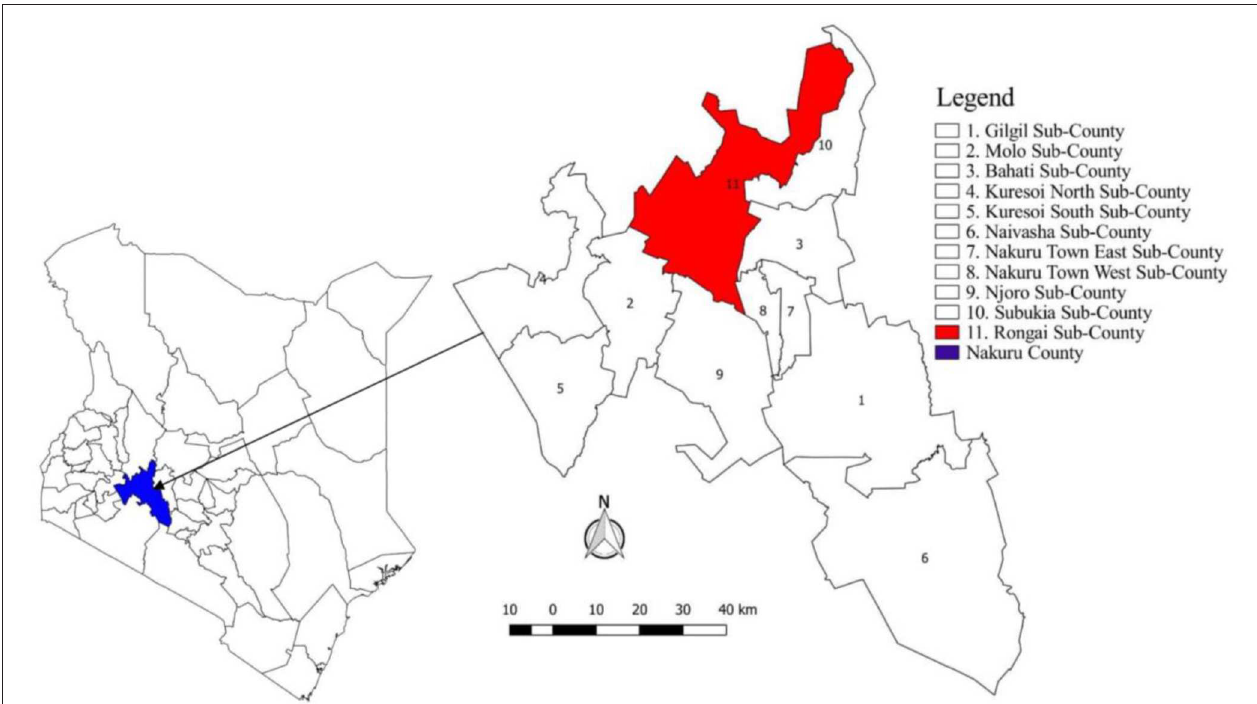
FIGURE 1 | Map of Kenya showing the location of Nakuru County and 11